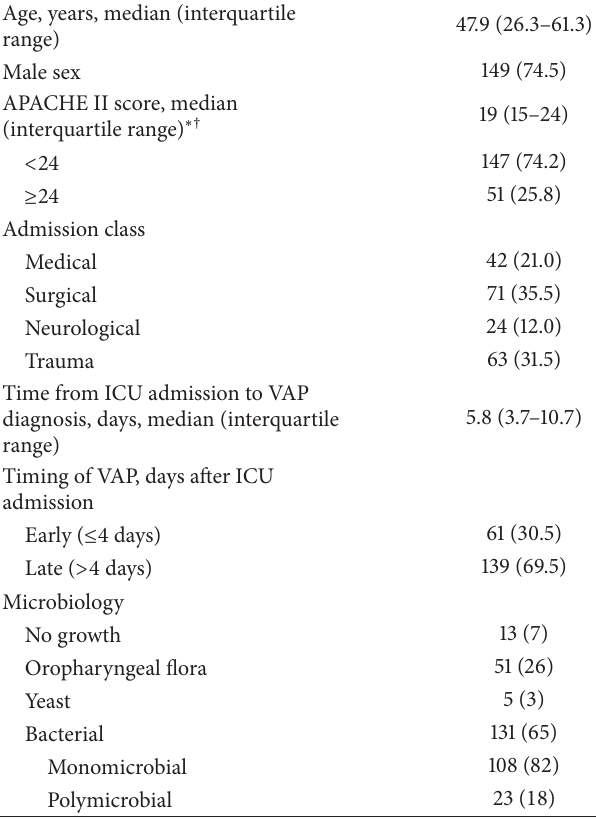
Table 1: Patient characteristics (total number of VAP cases = 200). Table 2: VAP bacterial pathogens (total number of VAP cases =